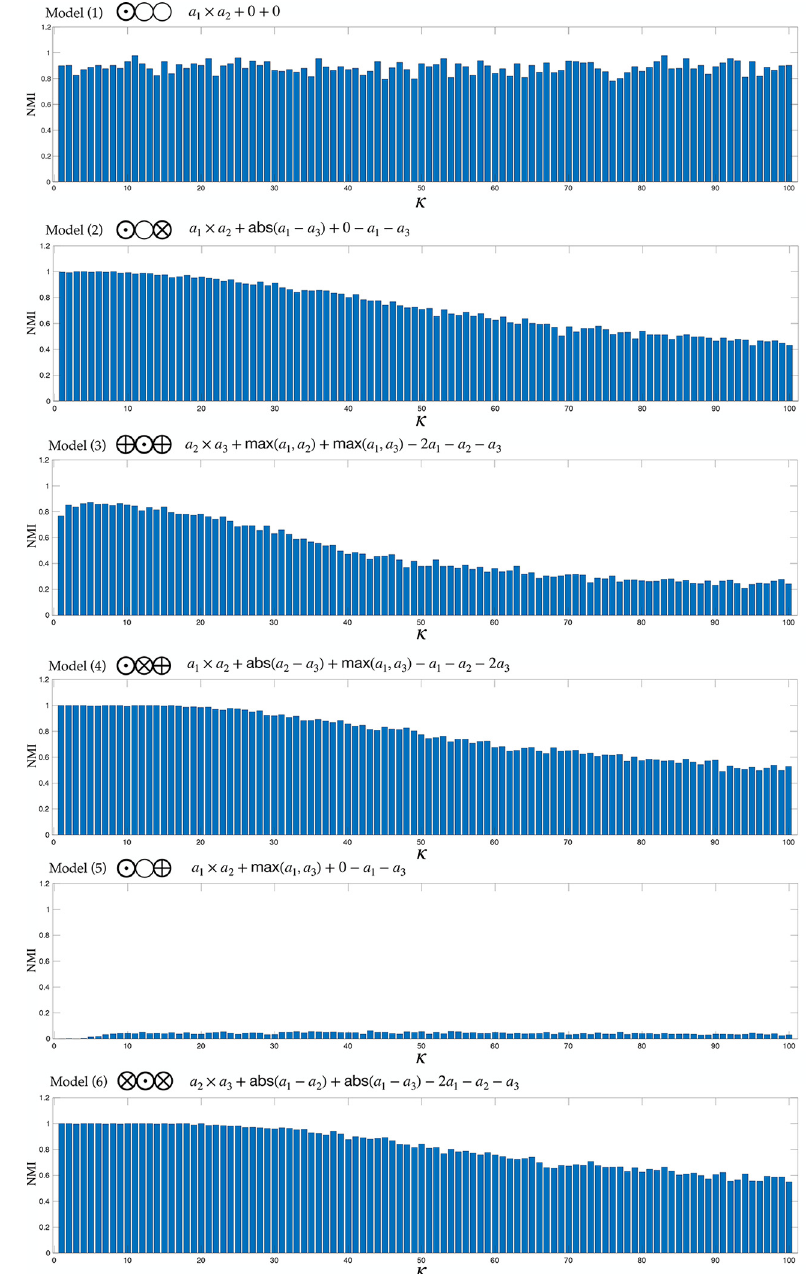
Figure 6. In fl uence of noise parameter on